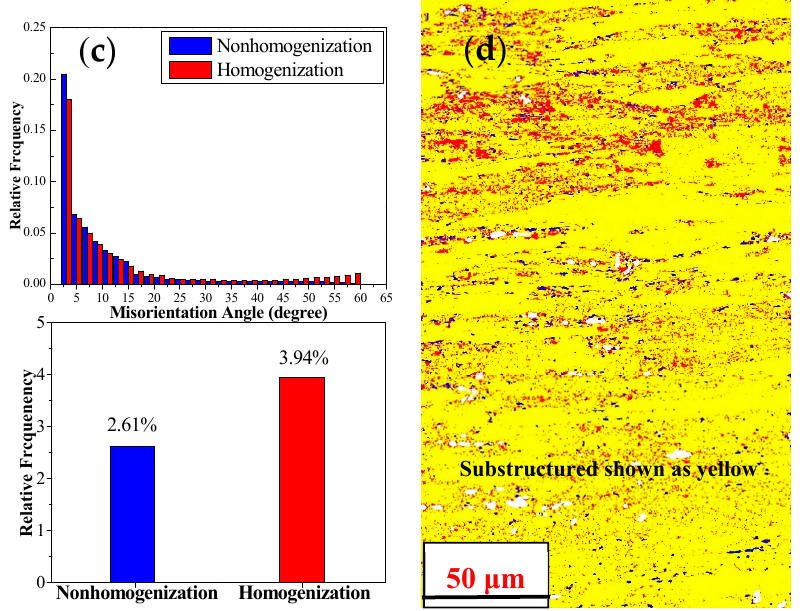
Figure 11. Electron backscattered diffraction (EBSD) images of grain structure for the two different homogenized samples after hot deformation: ( a ) orientation map and grain boundary map of nonhomogenized sample after forging; ( b ) orientation map and grain boundary map of homogenized sample after forging; ( c ) misorientation angle distribution and the recrystallized fraction of nonhomogenized and homogenized sample after forging; ( d ) the corresponding recrystallization map of homogenized sample after forging.